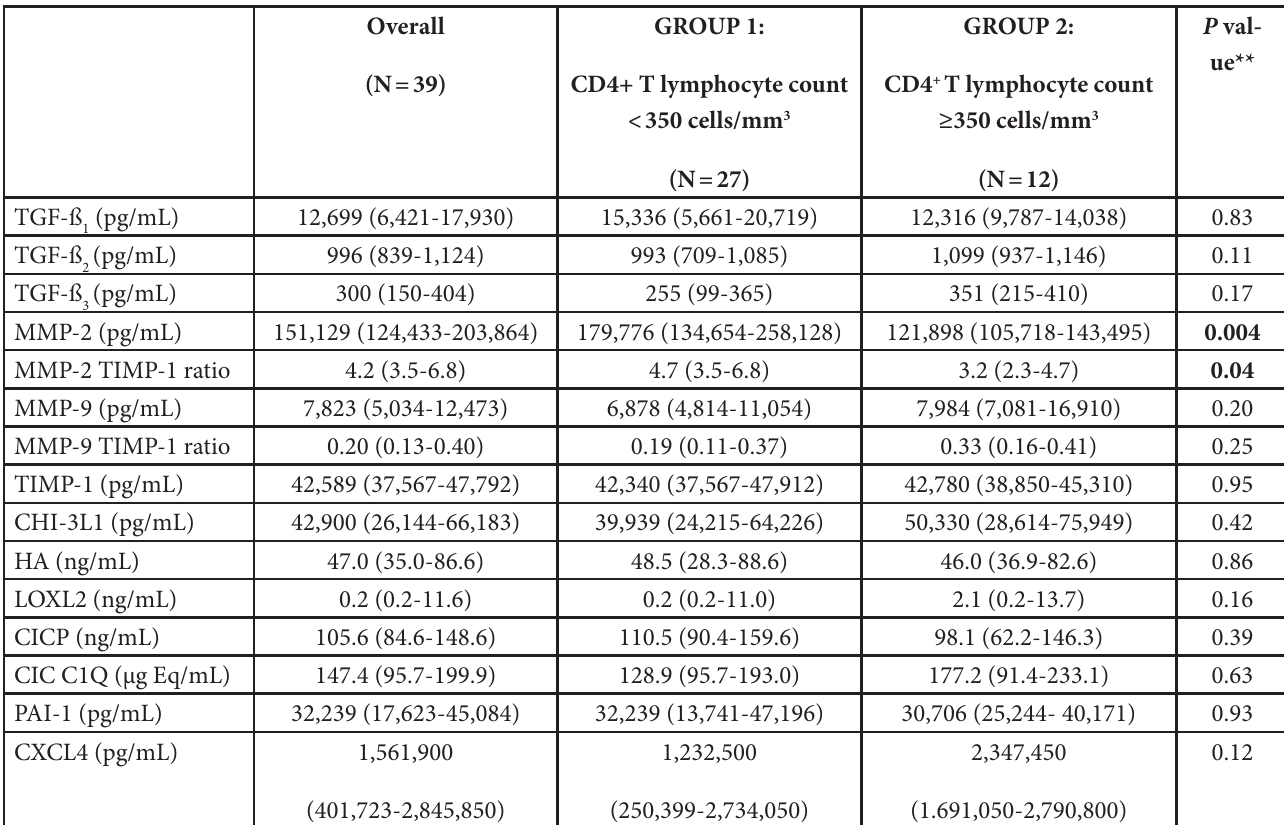
Table 2 : Circulating fibrosis biomarker levels among HIV+ aviremic individuals and by im- mune reconstitution